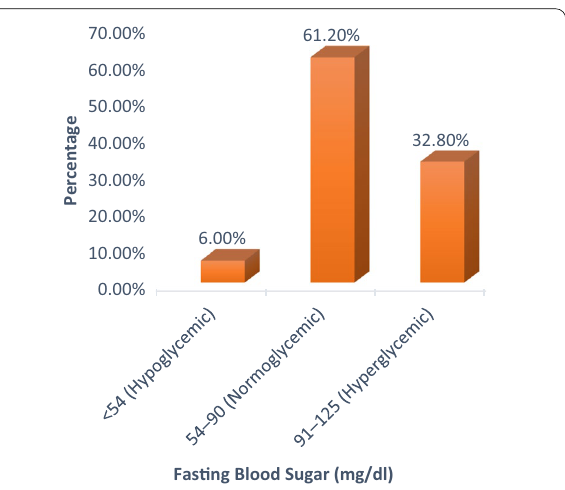
134) Fig. 3 Distribution of fasting blood sugar among =